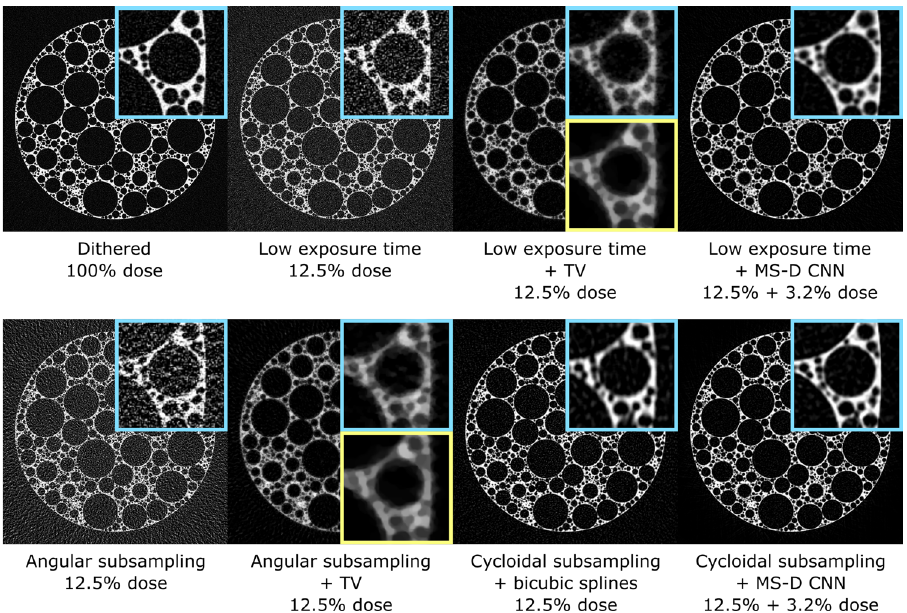
Figure 5. Tomographic images reconstructed from the simulated sinograms for the numerical foam sample, from left to right and top to bottom: reconstruction from complete data, from low exposure time data, from low exposure time data using TV reconstruction, from low exposure time data with projection denoising using a MS-D CNN 44 , from angularly subsampled data, from angularly subsampled data using TV reconstruction, from cycloidally subsampled data processed with bicubic splines interpolation, from cycloidally subsampled data processed with MS-D CNN data recovery. For each image, a small section is shown enlarged in the top right. For TV reconstruction, the parameter controlling the strength of the TV term was chosen such that the PSNR is maximized. In the bottom right of the TV reconstructions, the same small section is shown for a parameter choice that maximizes the MS-SSIM, showing the significant effect that this parameter has on the reconstructed image.